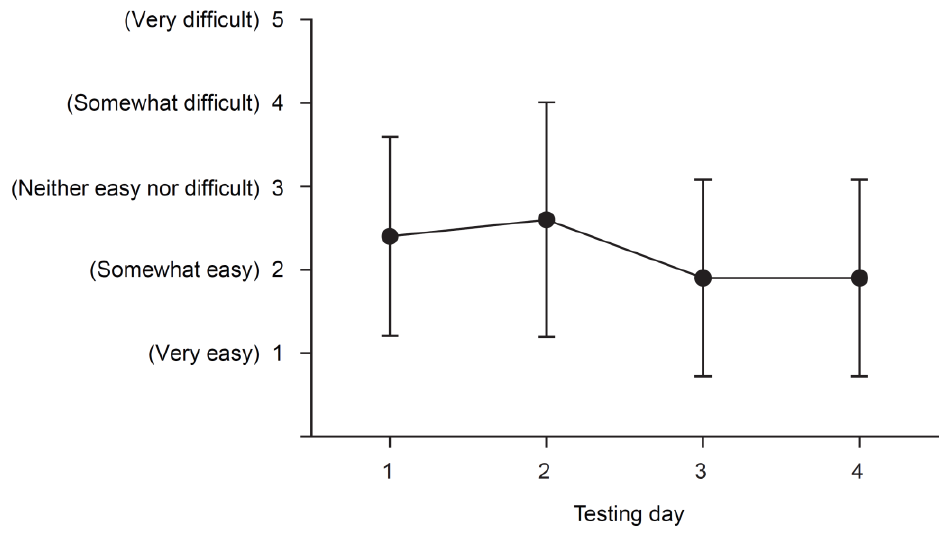
Figure 4. Assessment of ease of pimavanserin capsule manipulation. Data shown are the mean (SD) of participant assessments ( n = 16) of ease of capsule manipulation, defined as opening and emptying capsule contents. SD = standard deviation. Table 2. Treatment-emergent adverse events in the full analysis